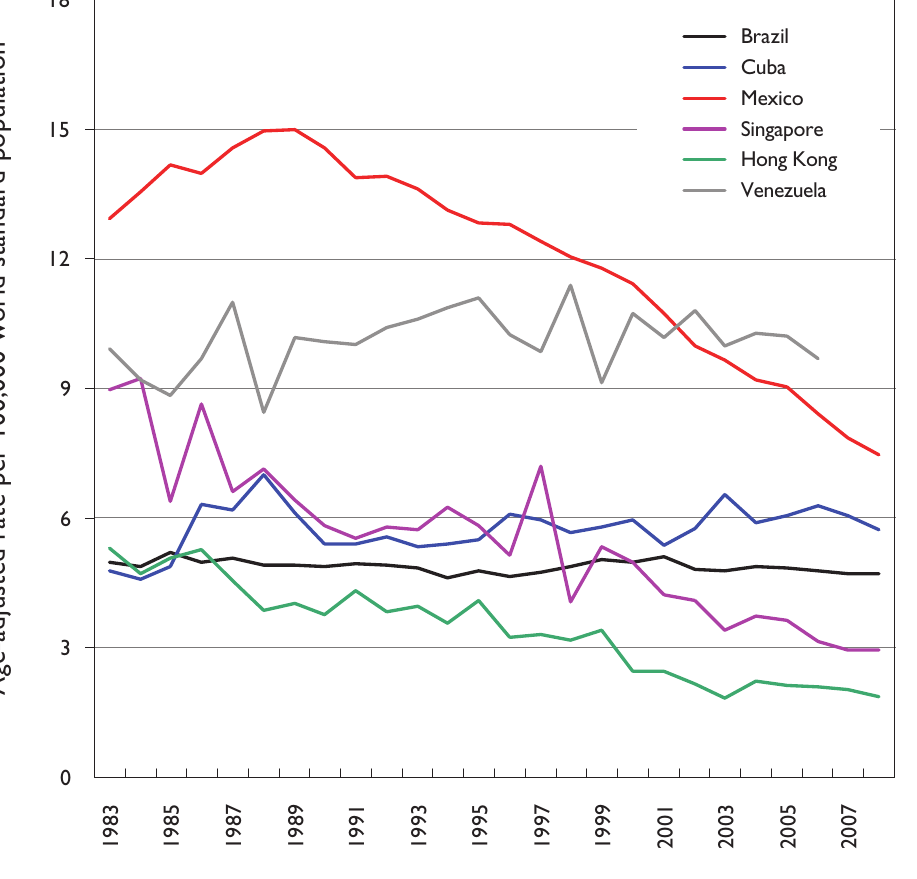
Figure 3. Trend in Cervical Cancer Mortality Rates in Selected Countries, 1983-2008